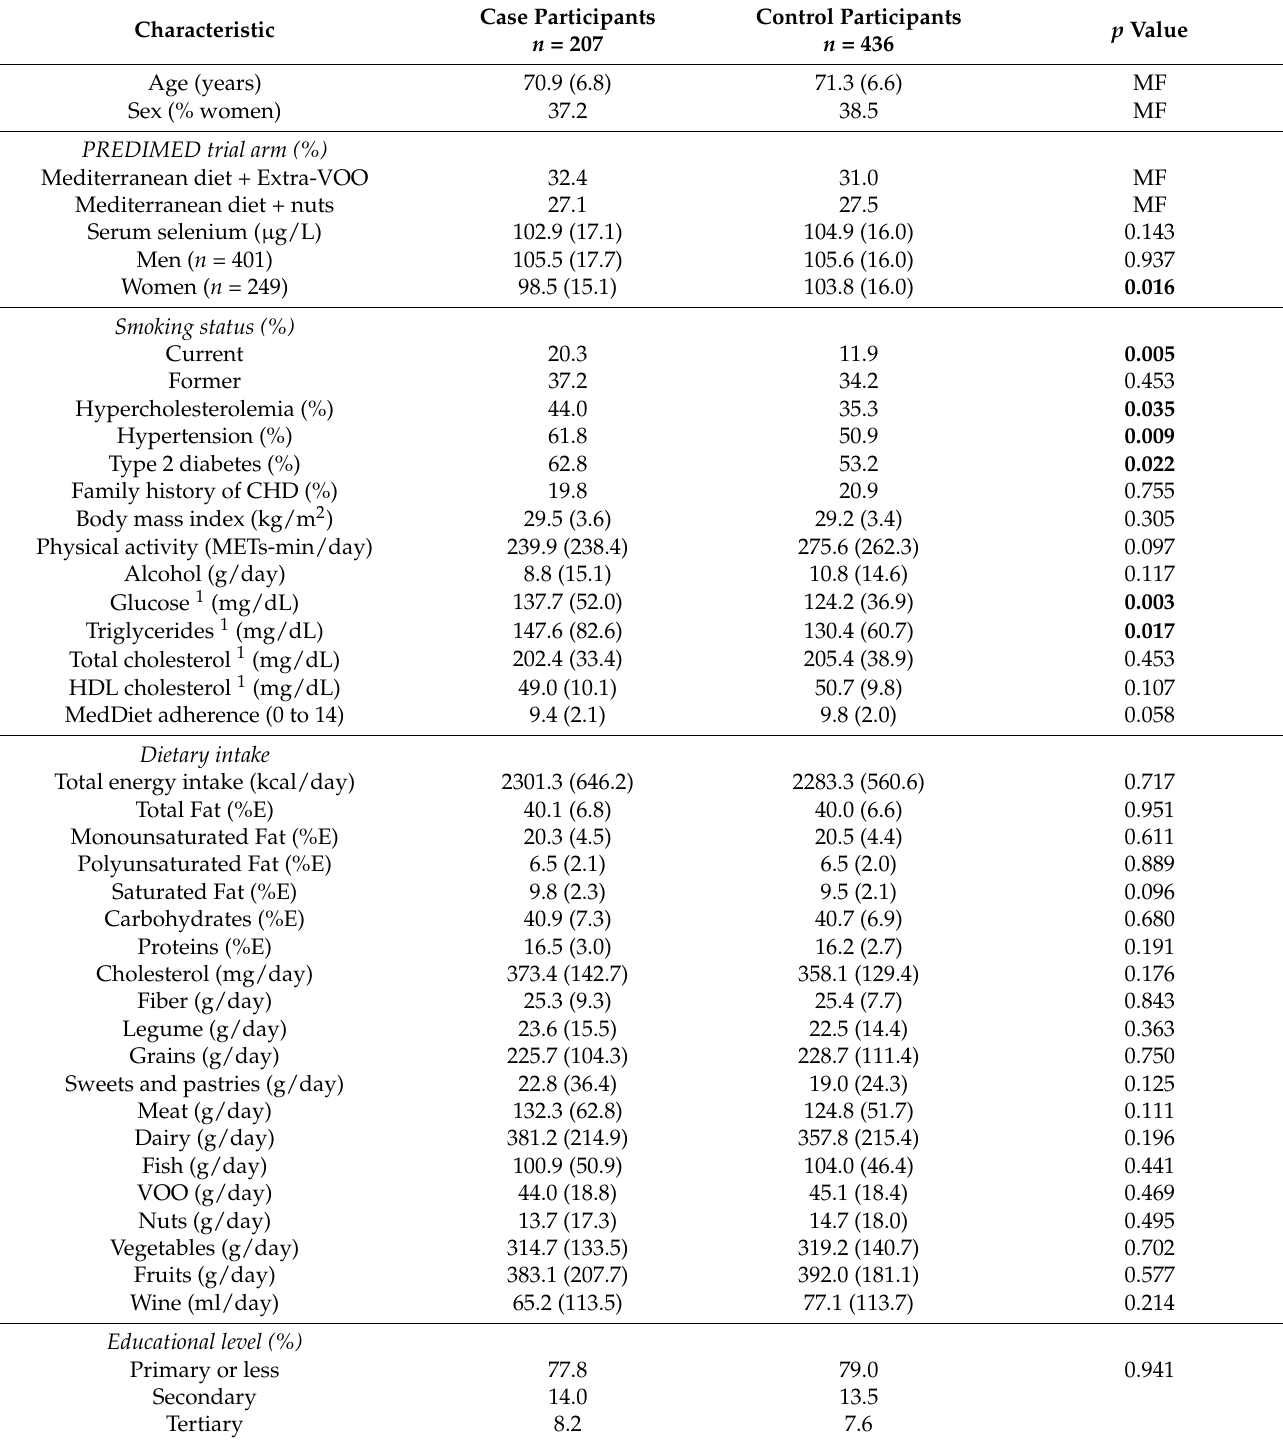
Table 1. Characteristics of cases and matched controls at sample collection time. The PREDIMED